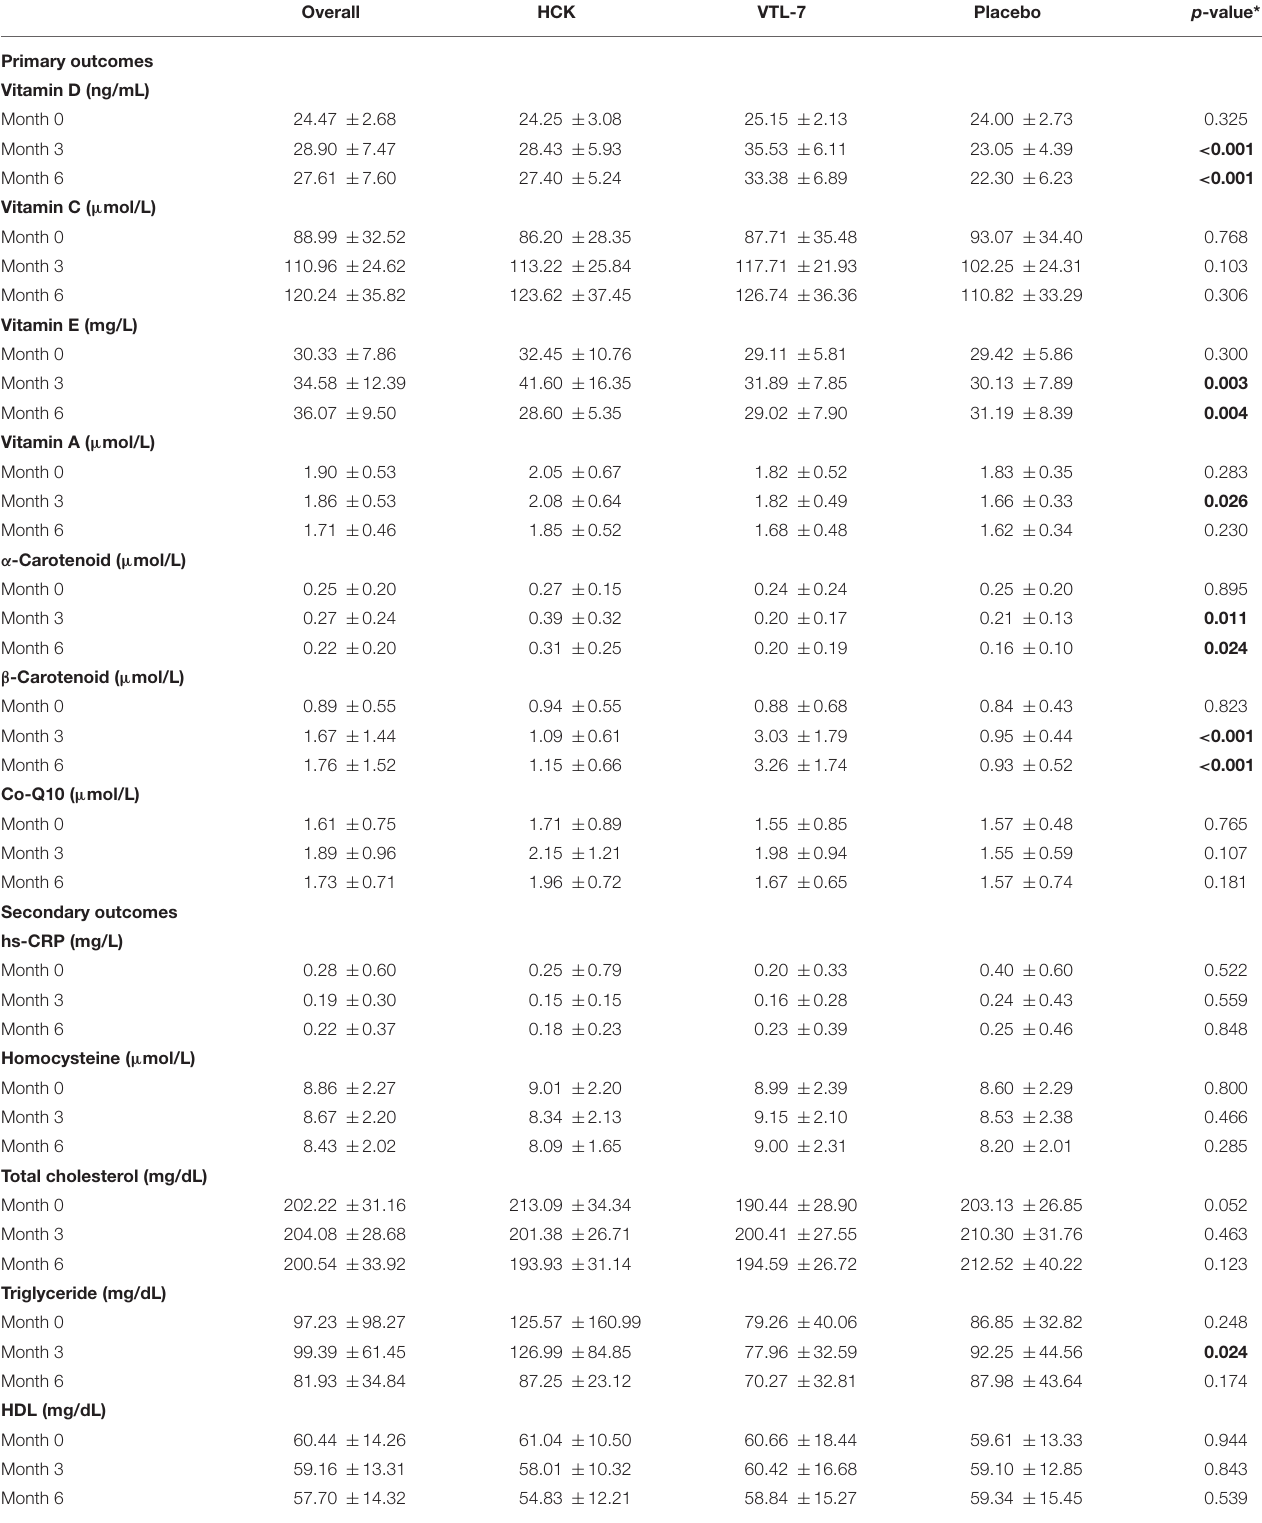
TABLE 2 | Laboratory outcomes and quality of life at baseline, month 3 and 6. Overall HCK VTL-7 Placebo p